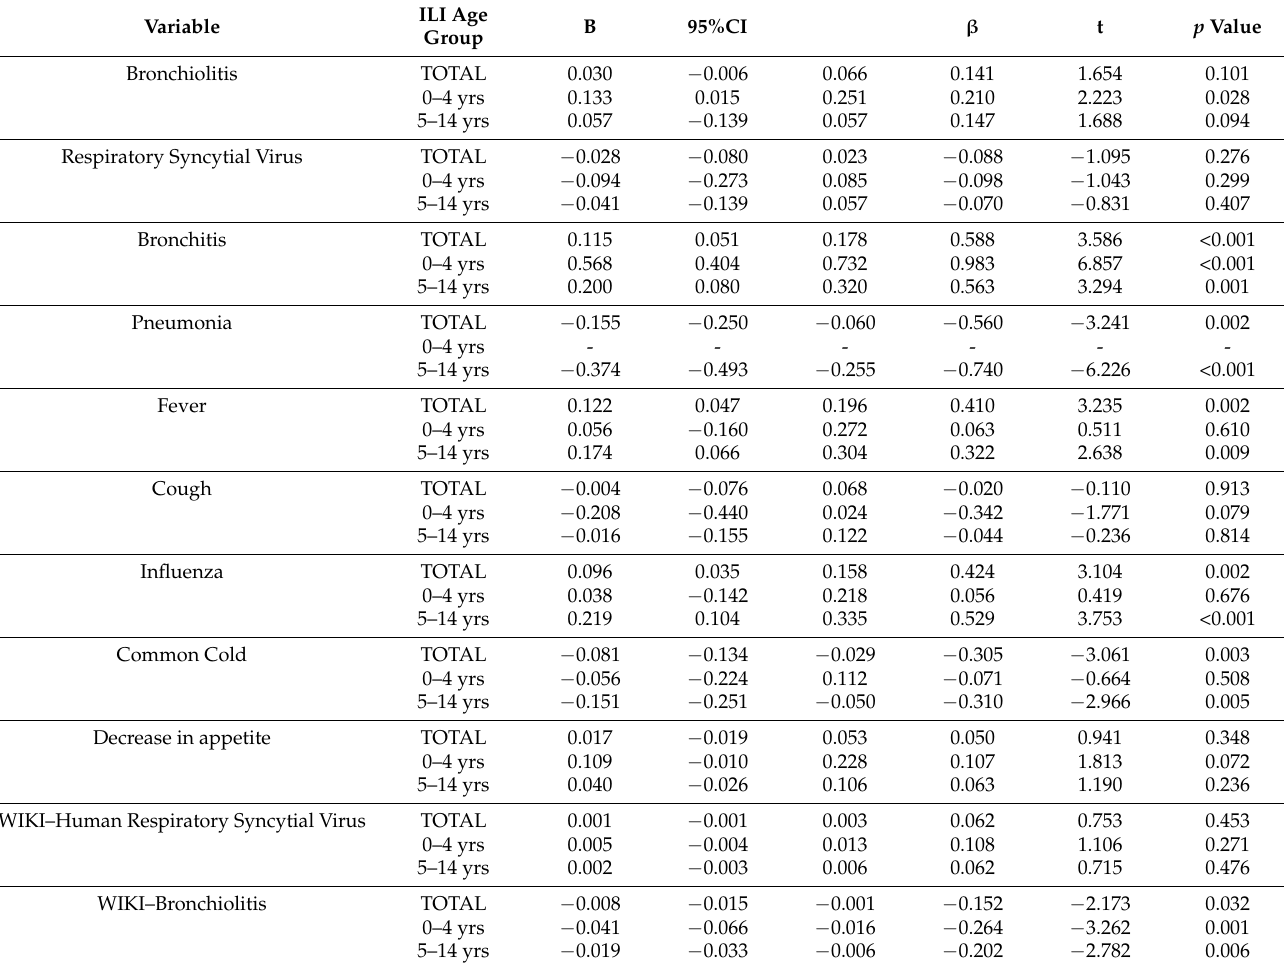
Table 8. Regression analysis for the outcome variables represented by Influenza-Like Illnesses (ILI) estimates and main assessed keywords from Google Trends TM , and topics from Italian Wikipedia, that in univariate analysis were associated by Spearman’s test p < 0.001. Analyses were performed by total sample (i.e., Total), and age groups 0–4 years, and 5–14